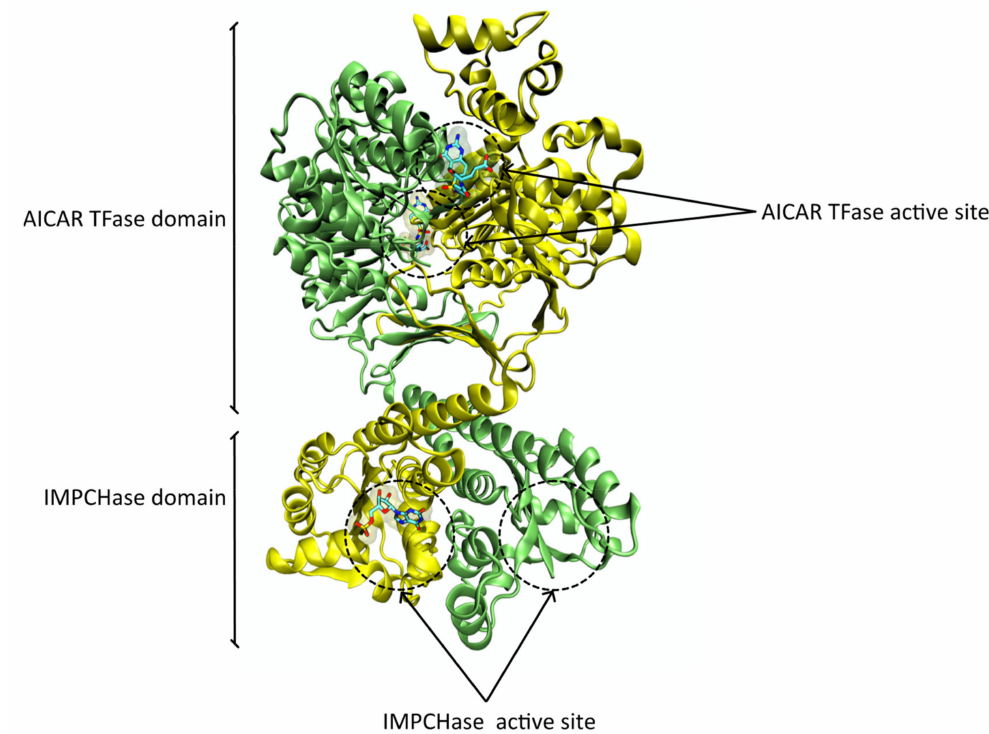
Figure 7. Ribbon representation of the human ATIC enzyme with the PDB ID 1P4R [57] obtained with VMD. The AICAR TFase active site harbors the folate-based inhibitor BW1540U88UD, and the IM- PCHase active site (of the ATIC monomer colored in yellow) harbors a xanthosine 5 (cid:48) ->monophosphate molecule. All ligands are represented in